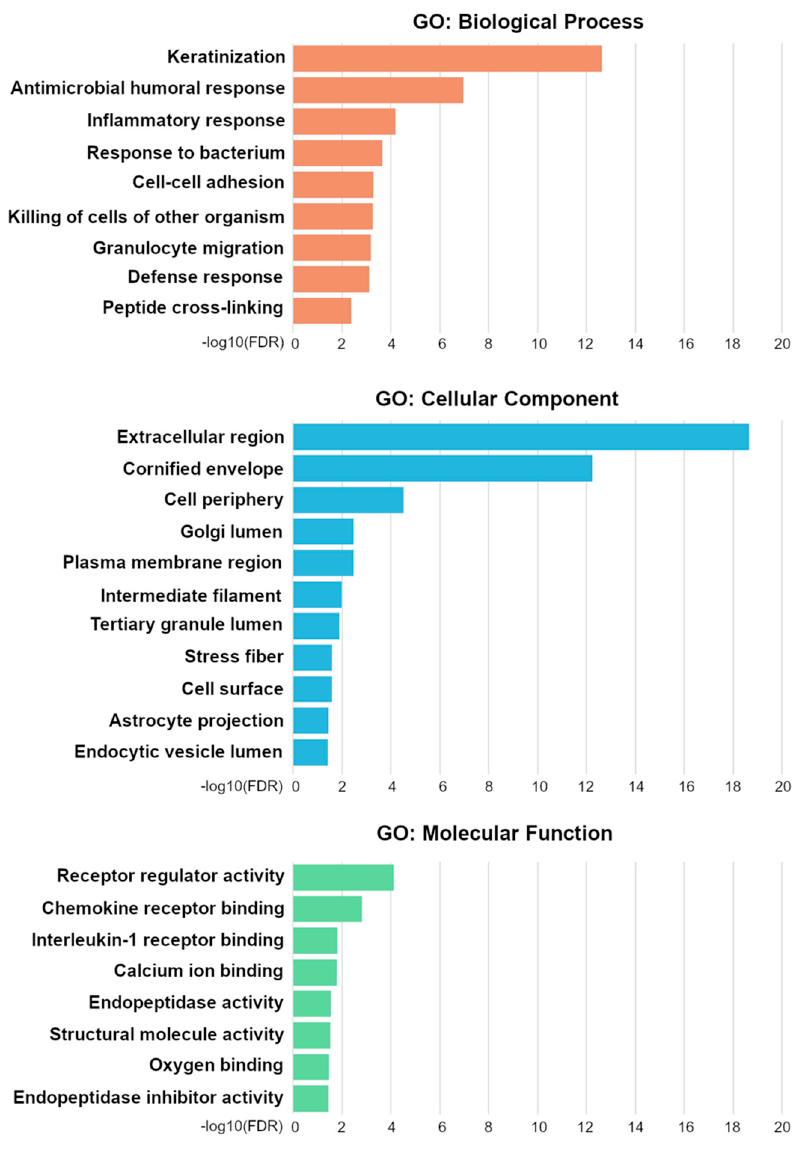
Figure 3. Gene ontology (GO) terms from enrichment analysis of differentially expressed genes. For hierarchically related terms, only the one with the lowest FDR is included. FDR, false detection rate.